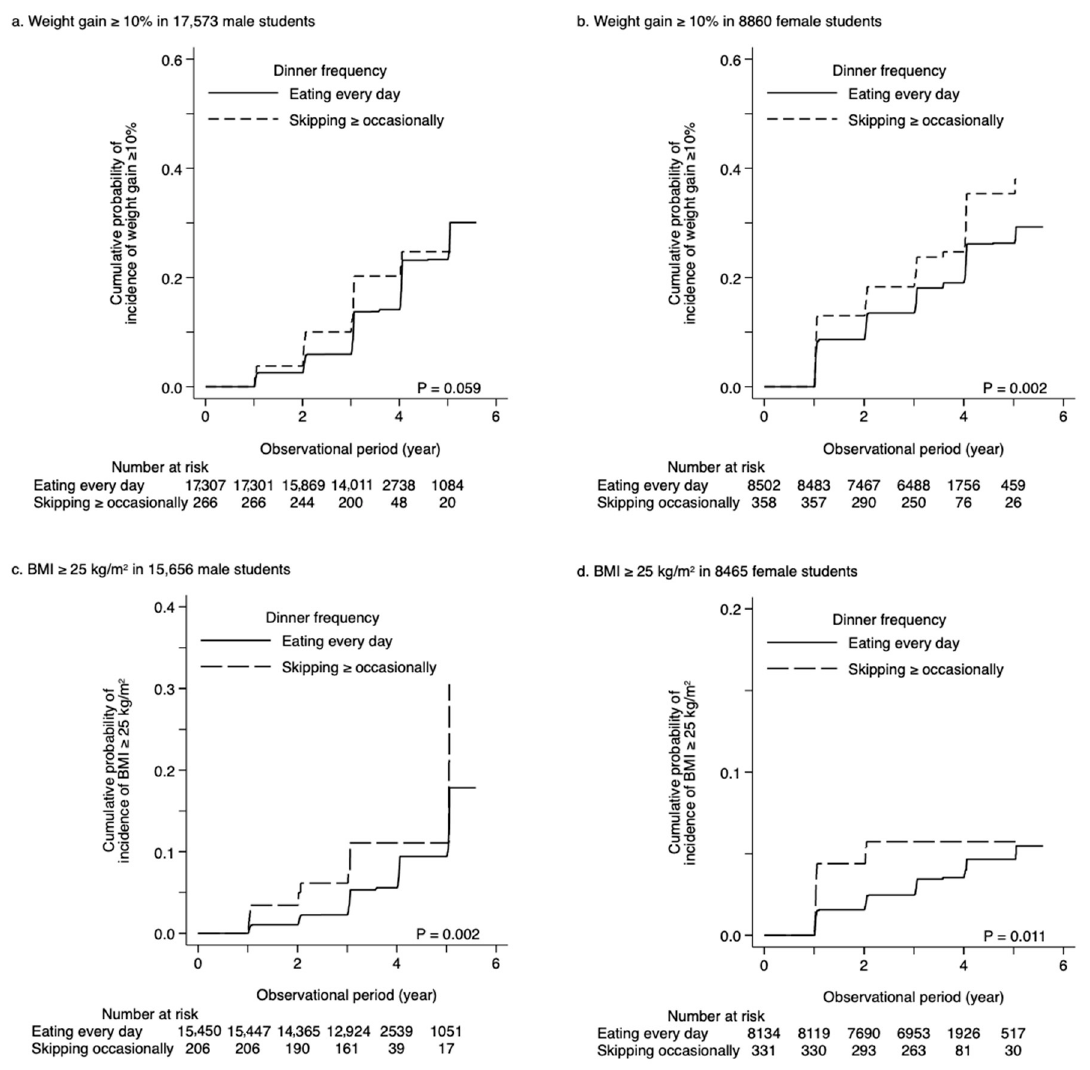
Figure 2. Dinner frequency and the cumulative probabilities of the incidence of ≥ 10% weight gain ( a , b ) and BMI ≥ 25 kg/m 2 ( c , d ) in male ( a , c ) and female ( b , d ) students. BMI, body mass index. After excluding 1917 (10.9%) male and 395 (4.5%) female students with BMI ≥ 25 kg/m 2 , we assessed the association between meal frequency and the incidence of over- weight/obesity (BMI ≥ 25 kg/m 2 ) in students with a BMI of <25 kg/m 2 . The cumulative probability of male and female students skipping dinner ≥ occasionally was significantly